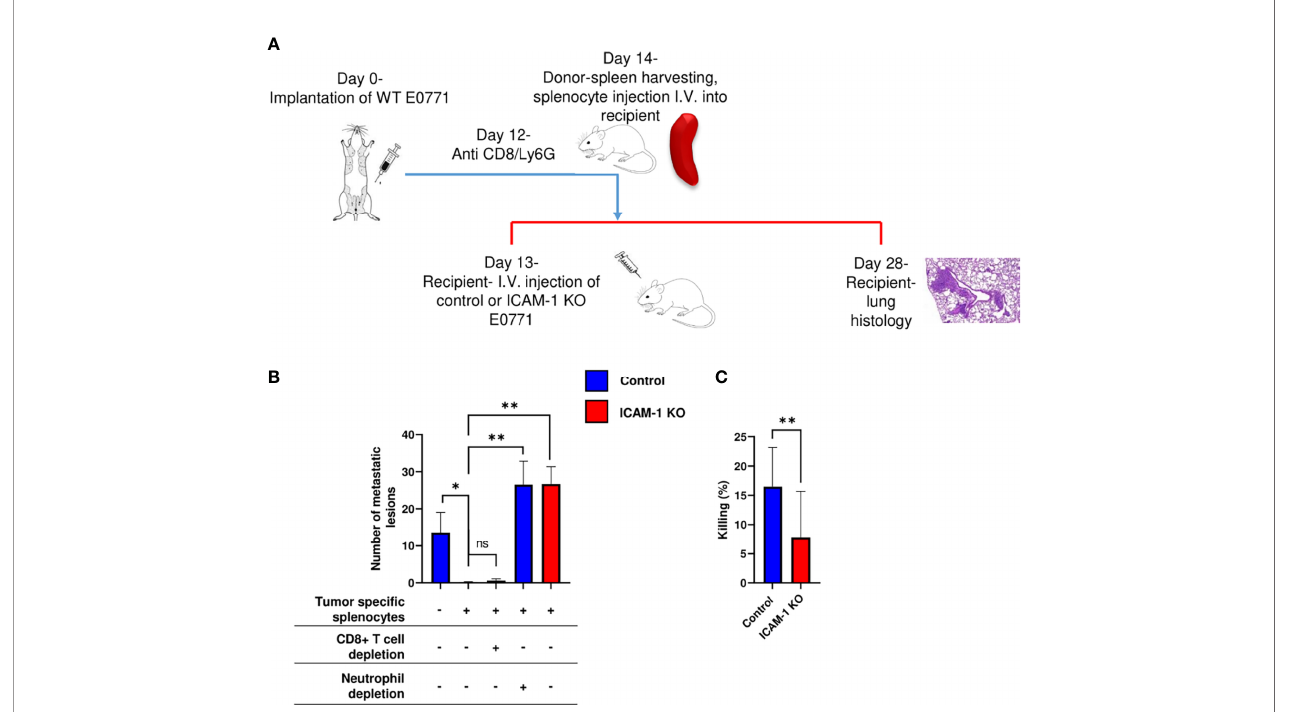
FIGURE 7 | Adoptively transferred neutrophils eliminate E0771 cells entering the lungs via breast cancer expressed ICAM-1. (A) A scheme of the experimental outline. Metastatic lesions developed by either control or ICAM-1 KO E0771 cells injected into the lungs of recipient mice was determined in the mice pretreated with either naïve or tumor entrained splenocytes isolated from donor spleens and introduced i.v. 24 h after E0771 injection. At the indicated groups, CD8+ T cells or neutrophils were depleted in donor mice with an i.p. injection of anti CD8 or Ly6G, respectively, 2 days before the adoptive transfer . (B) The number of metastatic lesions developed in recipient lungs subjected to the indicated treatments determined by H&E staining as in previous fi gures. The fi rst experimental group was transferred with naïve splenocytes. Each group consisted of 3 mice. * p <0.05. ** p <0.005 NS = non-signi fi cant. (C) In vitro killing of control or ICAM-1 KO E0771 cells by the blood-derived neutrophils of tumor-bearing mice determined in triplicates. n=12. ** p <0.005. The bars in B and C depict the mean values ±